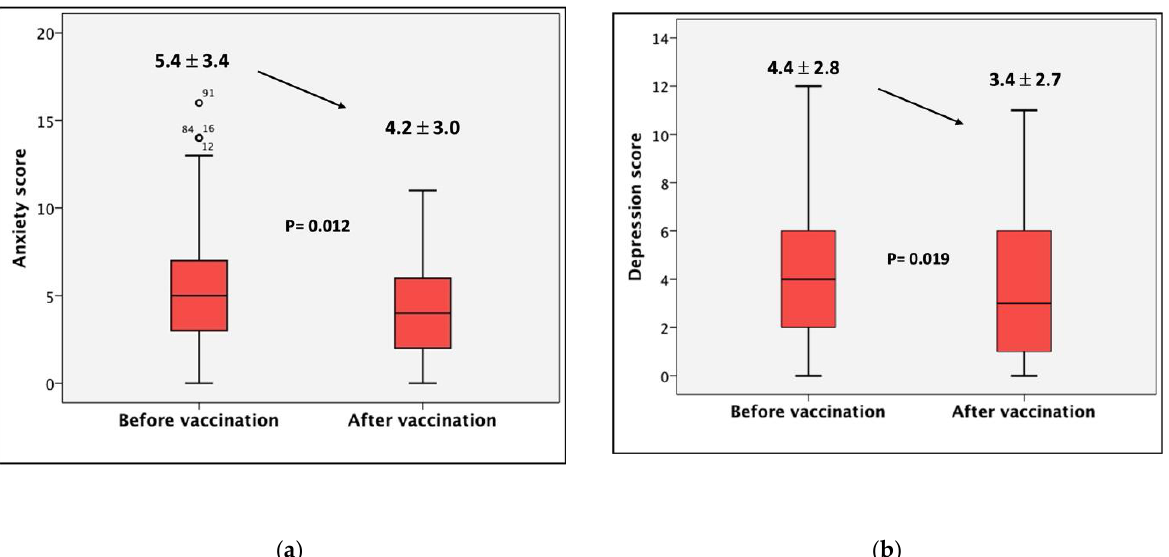
Figure 2. Comparative results of scores before and after vaccination (for all participants). The patients presented a significant improvement in both anxiety ( p = 0.012) and depression ( p = 0.019) scores two weeks post-vaccination. ( a ) The left panel shows anxiety score before vaccination and two weeks after the second dose of vaccination. Before vaccination: mean ± standard deviation: 5.4 ± 3.4, median: 5 (IQR: 3–7). After vaccination: mean standard deviation: 4.2 ± 3.0, median: 4 (IQR: 2–6). p = 0.012 Mann − Whitney U test. ( b ) The right panel shows the depression score before vaccination and two weeks after the second dose of vaccination. Before vaccination: mean ± standard deviation: 4.4 ± 2.8, median: 4 (IQR: 2–6). After vaccination: mean ± standard deviation: 3.4 ± 2.7, median: 3 (IQR: 1–5). p = 0.019 Mann − Whitney U test. Before vaccination, n = 117. After vaccination, n =